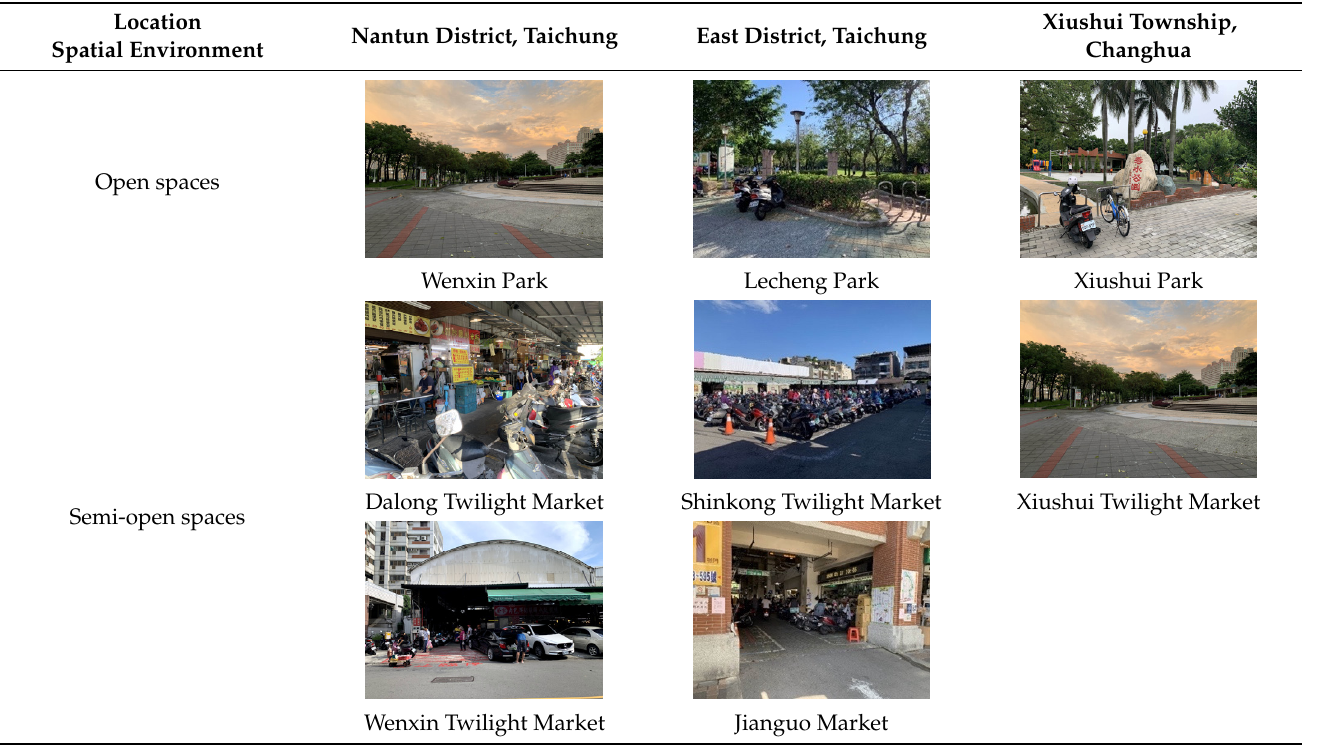
Table 1. Photos of observation sites.